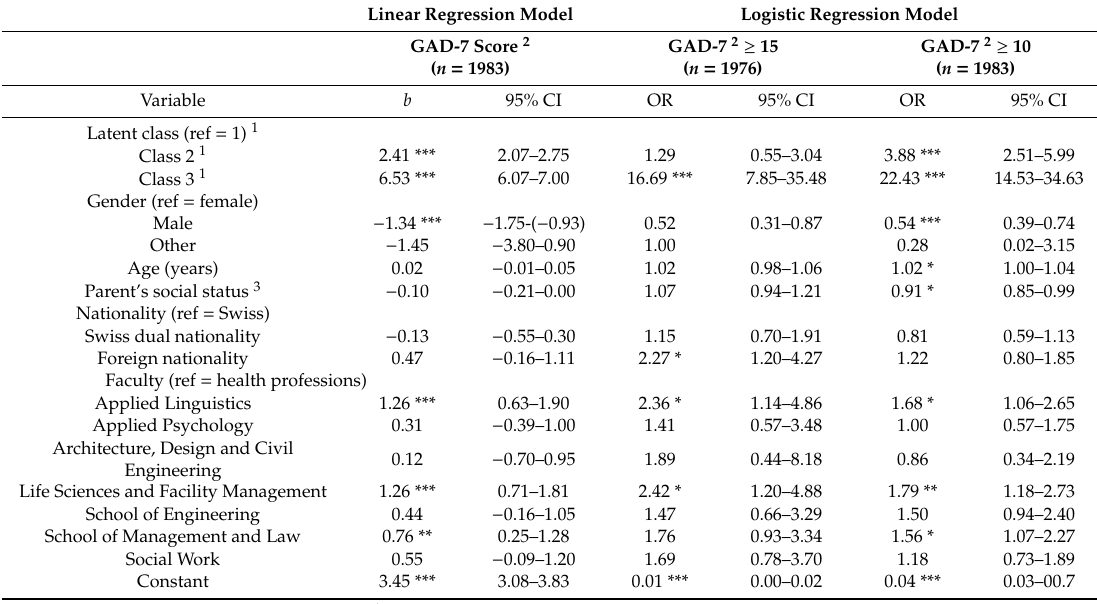
Table 3. Association between latent classes and General Anxiety Disorder scale